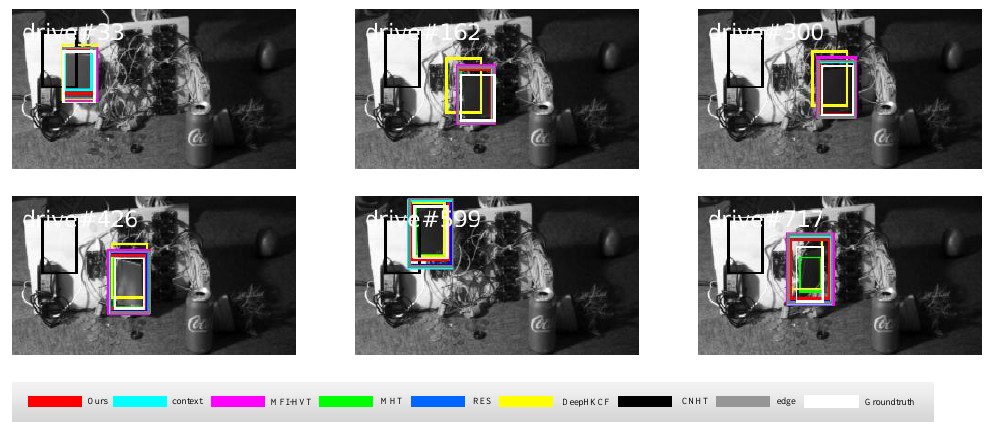
Figure 15. Qualitative outcomes for the drive sequence. In Figure 16, the target walks in front of the trees and a portion of the forest causes occlusion of the target. Hence, MFI-HVT and DeepHKCF, which use depth features, lose the target from frame 338 onward. However, our tracker is able to accurately locate the target and adapt to the changes in the